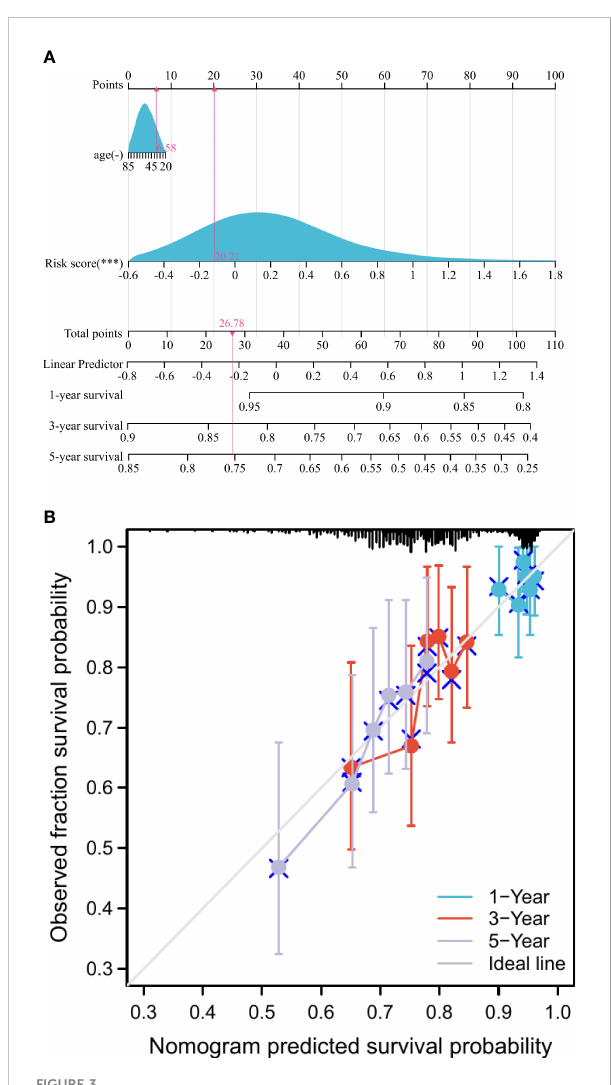
FIGURE 3 Construction and assessment of the nomogram. (A) Development of nomograms for predicting prognosis. (B) Calibration curve for predicting 1-, 3-, and 5-year survival in breast cancer patients. ***p <